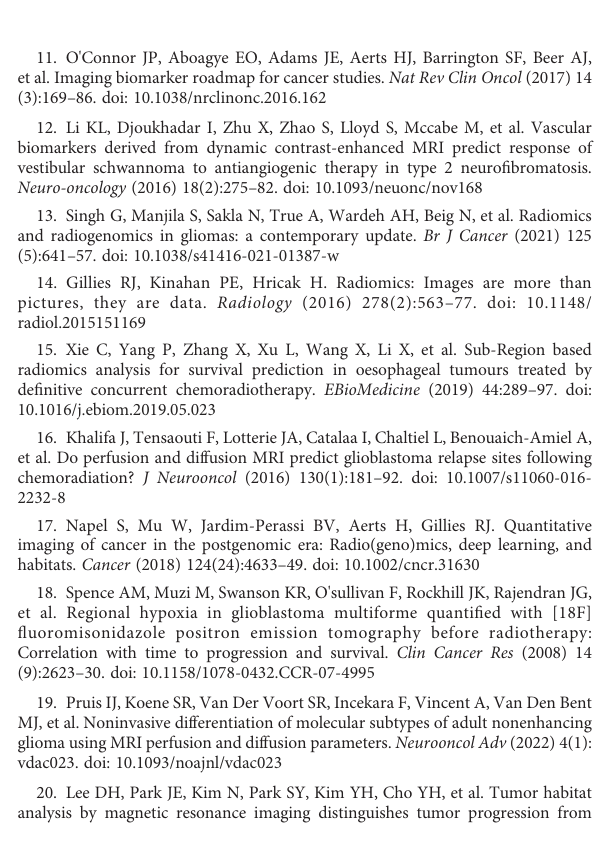
SUPPLEMENTARY FIGURE 1 Search strategy. To review the current evidence on imaging habitats, MEDLINE was queried systematically using the search terms described by two independent authors (MW, PVH) with discrepancies resolved through discussion with a third (EH). A total of 15 articles were included in the fi nal review relating to imaging habitats that are summarised in